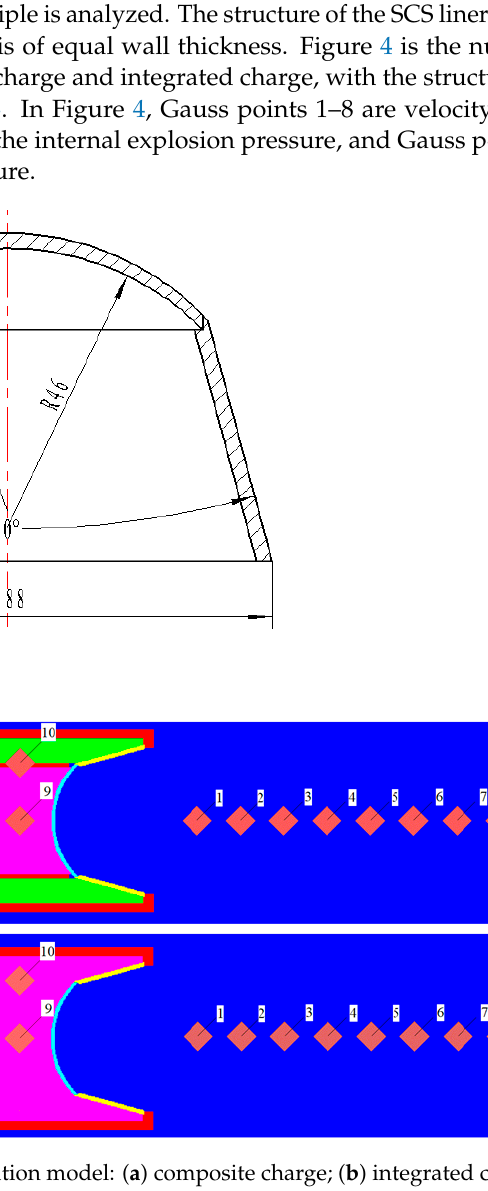
Figure 4. Numerical simulation model: ( a ) composite charge; ( b ) integrated charging.